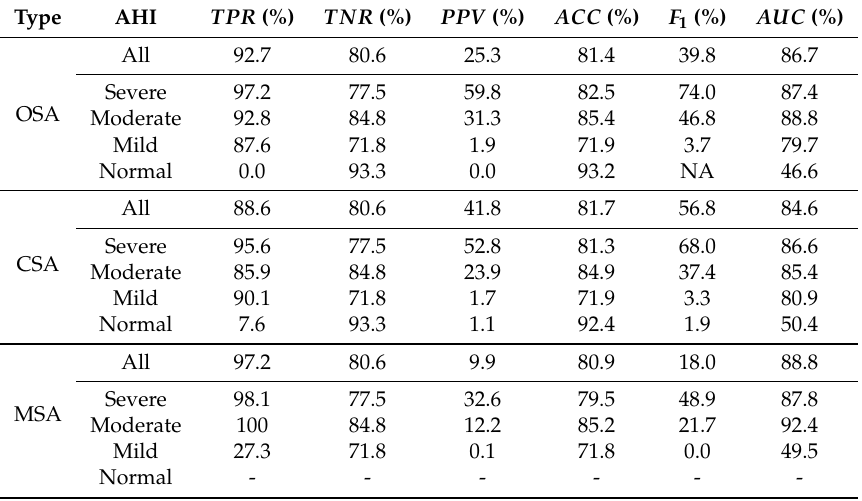
Table 6. Detailed test performance of AICPV with GMM classifier (AICPVwGMM) over different Apnea–Hypopnea Index (AHI) severities per apnea